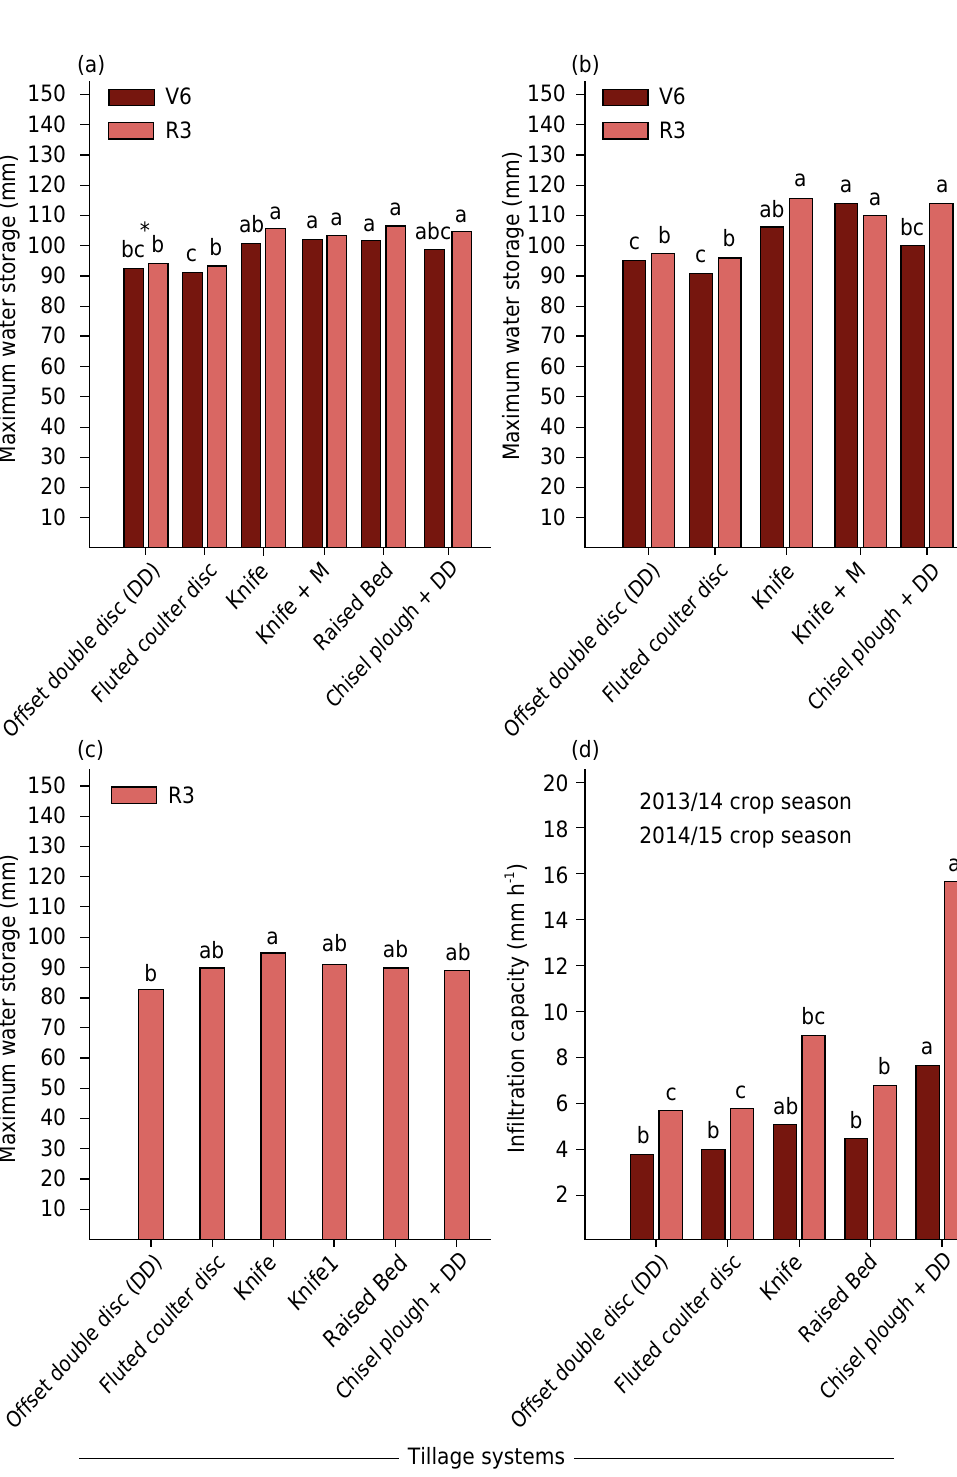
Figure 2. Maximum water storage in the soil at 0.0-0.2 m as a function of tillage systems in V6 and R3 plant growth stages in Santa Maria, 2013/14 (a) and 2014/15 (c) crop seasons; and Formigueiro 2013/14 crop season (b). Water infiltration capacity in soil in Santa Maria, Brazil (d). Experiment 1, 2013/14 and 2014/15 crop seasons. Bars followed by the same letters do not differ significantly by the Tukey test at 5 %